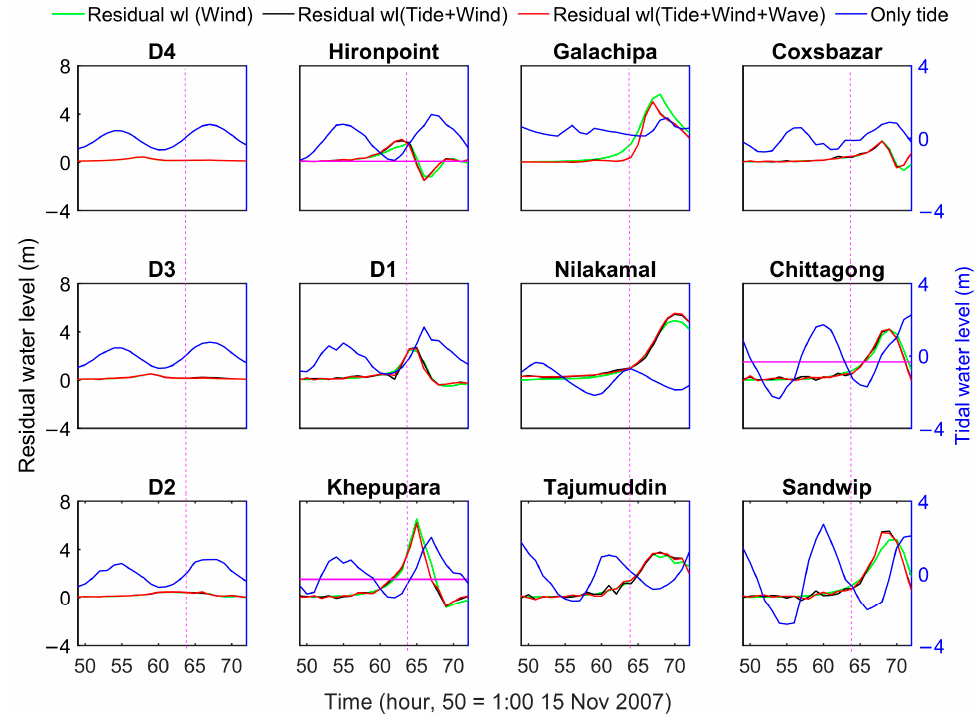
Figure 5. Model simulated tides and residual water levels at different stations during the landfall of Cyclone Sidr for the following scenarios: only tide (Run3 in Table 2), only wind (Run4), tide and wind (cyclonic wind stress increase along with tide, Run5), and the real case (cyclonic wind stress along with tide and wave, Run1). The residual water level is calculated by subtracting the tidal water level from the simulated total water level. The purple dashed line represents the landfall time.